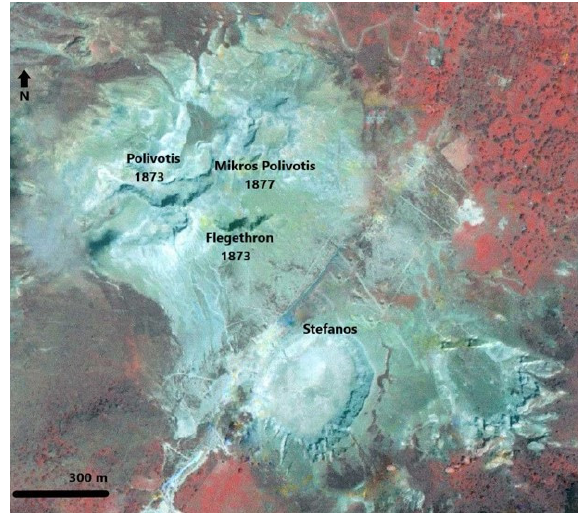
Figure 5. Satellite photo of the craters [58], modified.